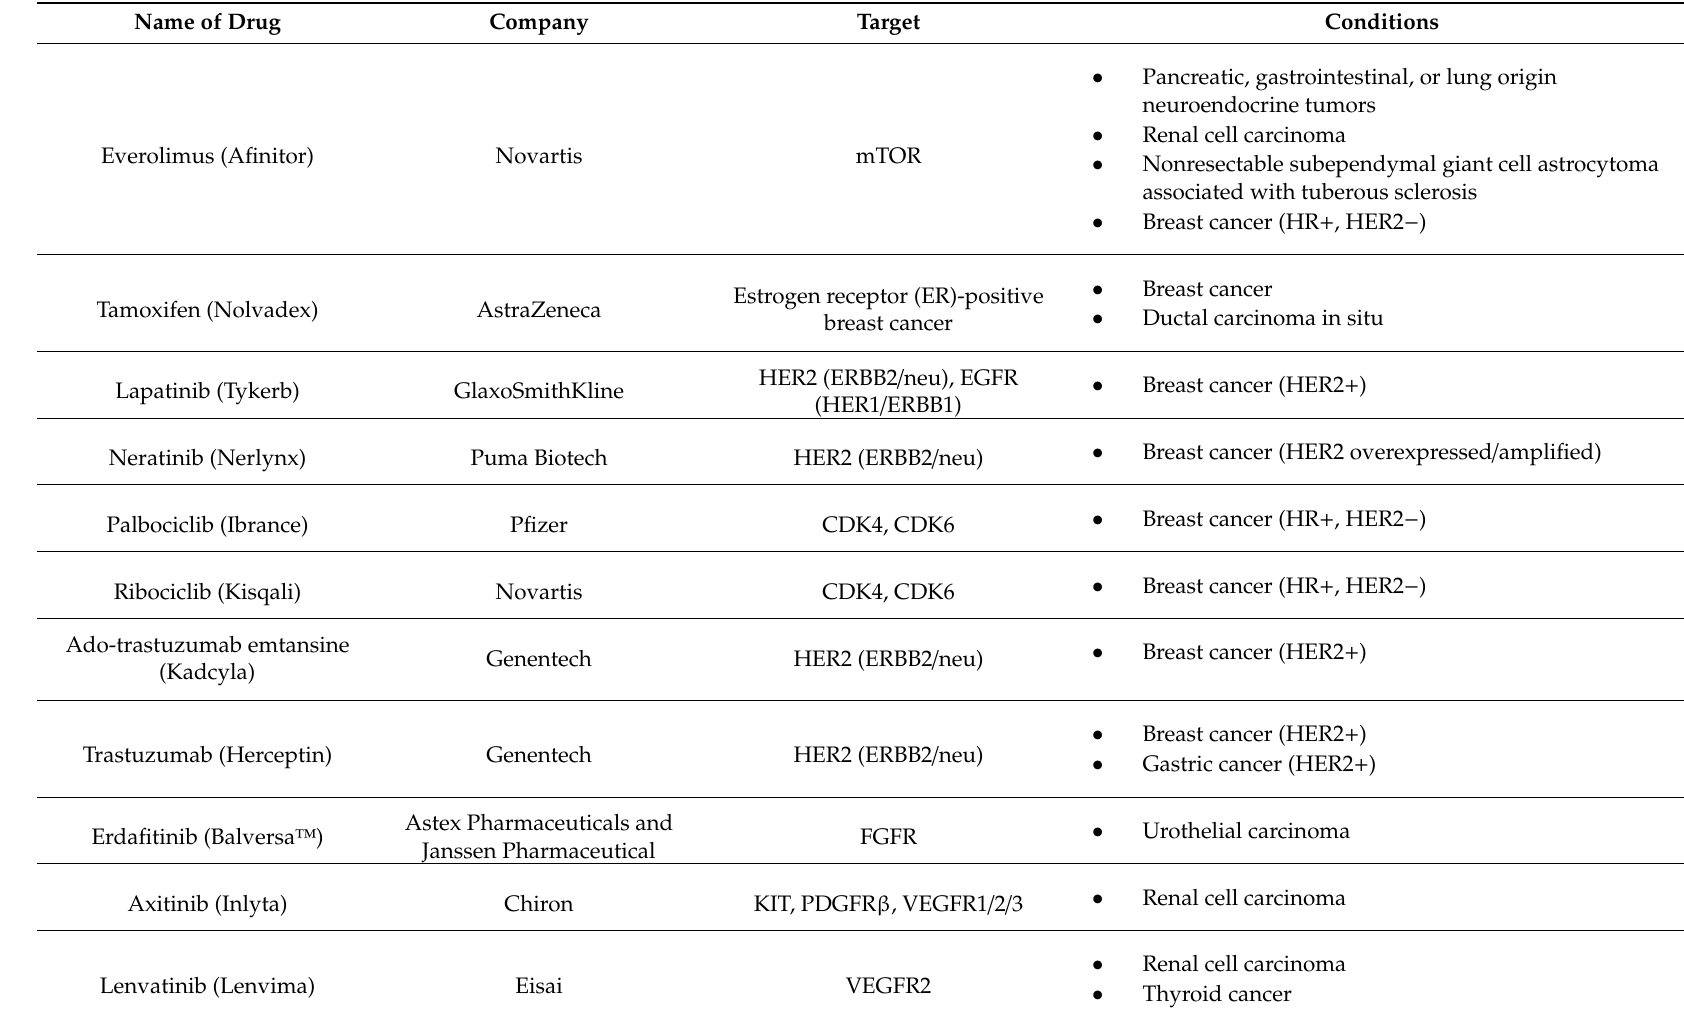
Table 2. Food and Drug Administration (FDA)-approved targeted therapies for